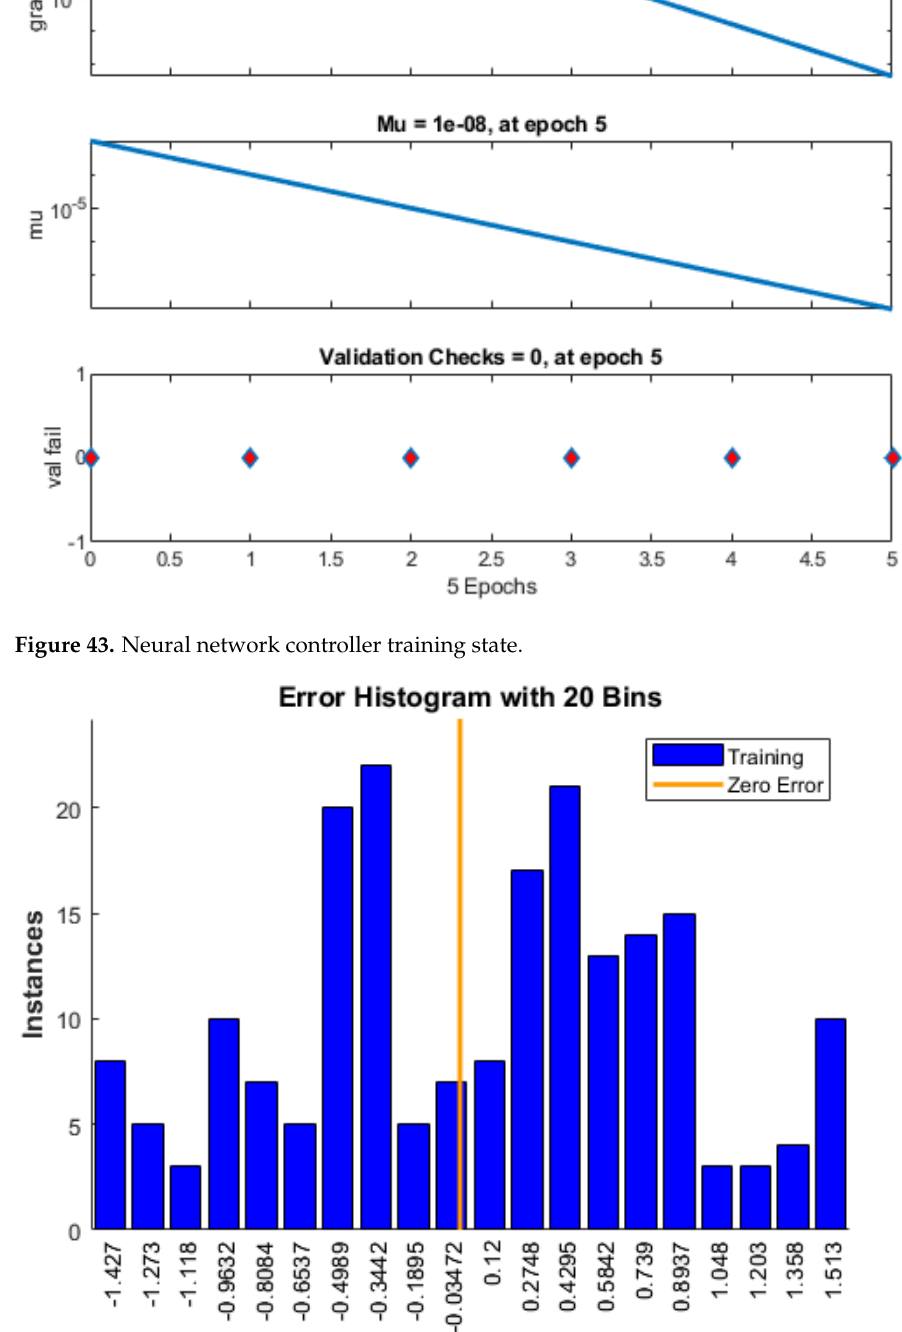
Figure 44. Neural network controller errors.